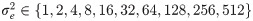
2D histogram showing the number of emerged communication systems that end up using a particular number of color terms when trained using a particular amount of environmental noise.25 experiments are run for each level of noise σe2∈{1,2,4,8,16,32,64,128,256,512}. Hence, each bin on the x axis shows the distribution over number of words resulting from that level of noise.